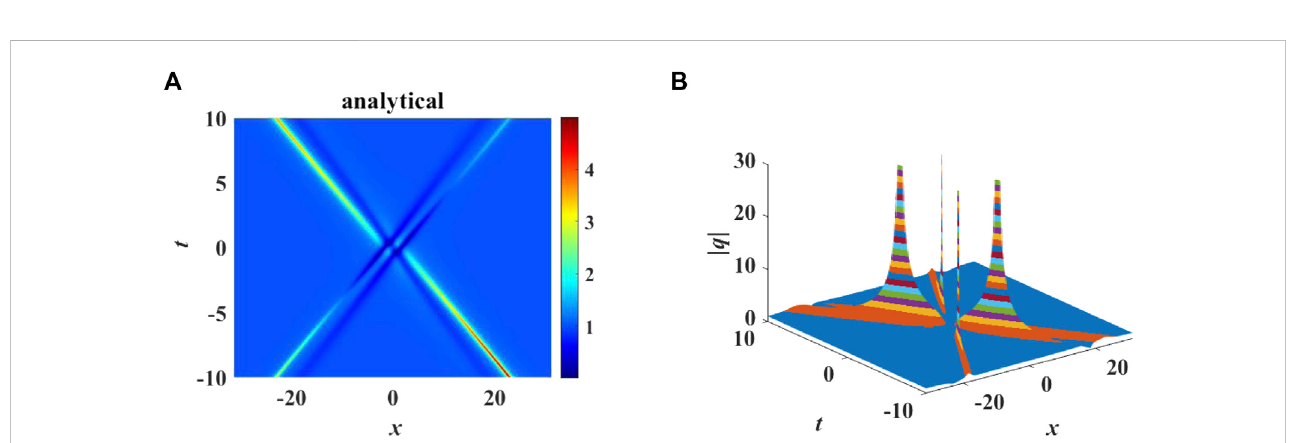
FIGURE 2 (A) Inelastic collision between two solitons with parameters κ = − 1, α = 1, β = 0.001, s 1 = 0.1 i , s 2 = 4 i , ρ = 1. (B) Second-order rational soliton solution with parameters κ = − 1, α = 1, β = 0.001, s 1 = 2 i , s 2 = 0, ρ =